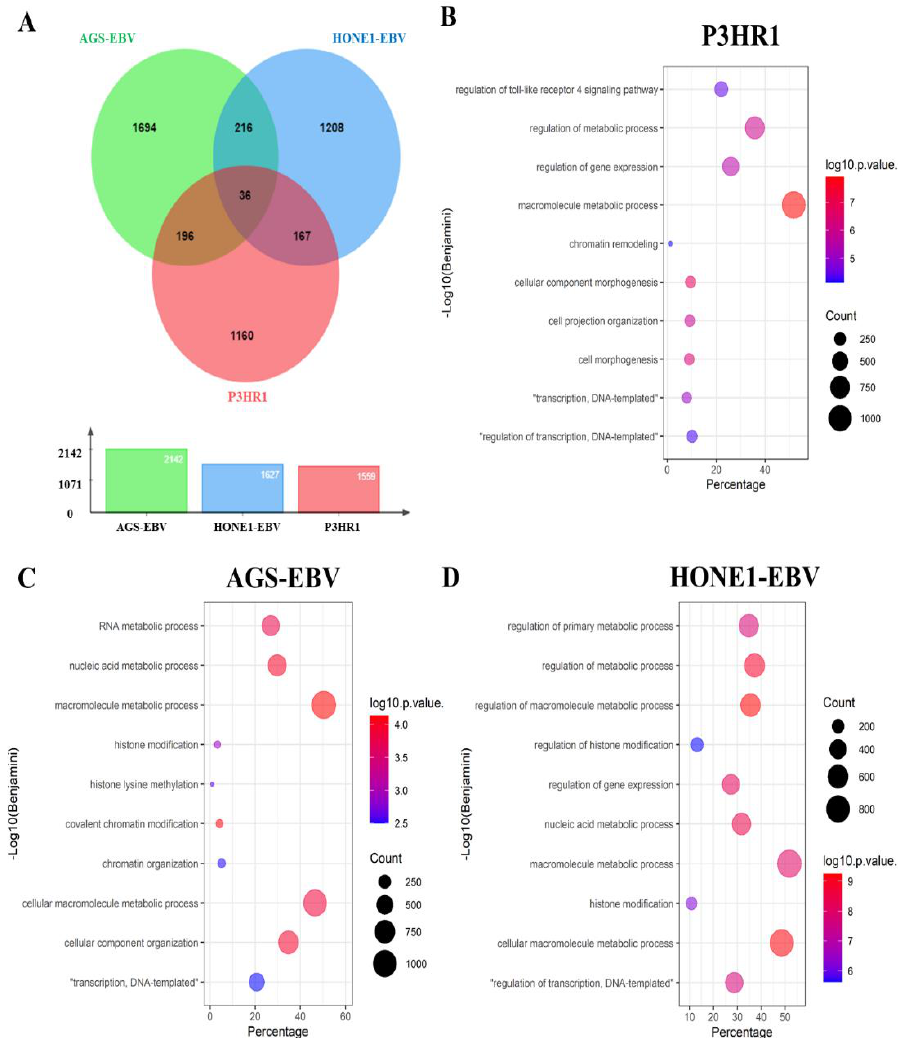
Figure 4. Venn diagram analysis of differential expressed proteins among EBV-positive cell lines (P3HR1, AGS-EBV and HONE1-EBV). Cells were either treated with DMSO (control), NaB or the